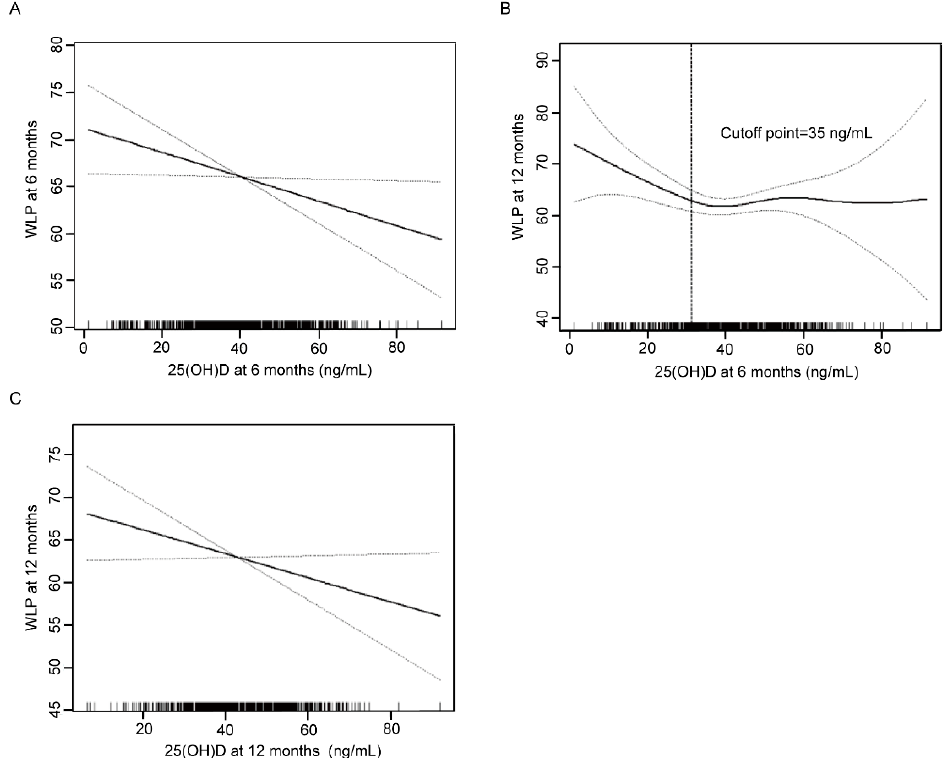
Figure 1. Association between 25(OH)D at 6 months and WLP at 6 months ( A ), 25(OH)D at 6 months and WLP at 12 months ( B ), 25(OH)D at 12 months and WLP at 12 months ( C ). Solid line represents the smooth curve fit between variables. Dotted line represents the 95% confidence interval from the fit. WLP, weight-for-length percentile. Table 3. Associations of 25(OH)D with weight-for-length percentile in infants at 6 and 12 months. Weight-for-Length